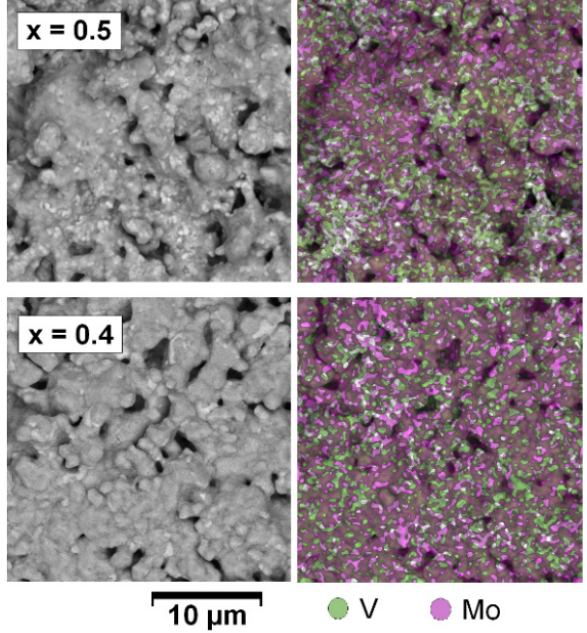
Figure 7. SEM images (BSE mode) of surface of CaV 1–x Mo x O 3 ± δ (x = 0.4 and 0.5) ceramic samples after oxidation at 1073 K and a O 2 = 10 − 15 atm with EDX maps of V and Mo distribution.